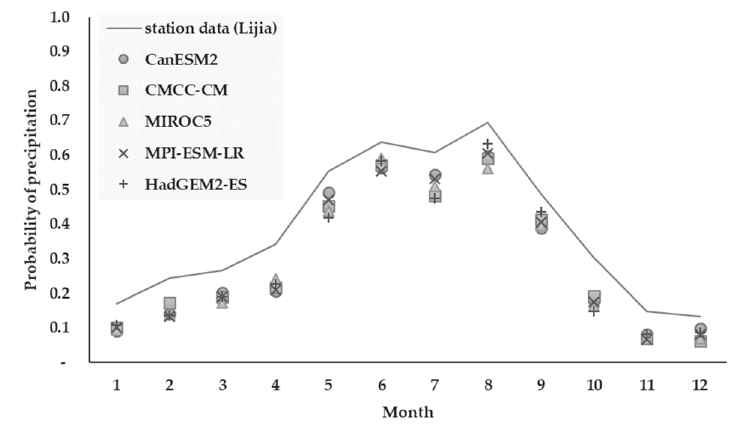
Figure 12. Bias correction result in probability of precipitation of the Fixed-Threshold method.